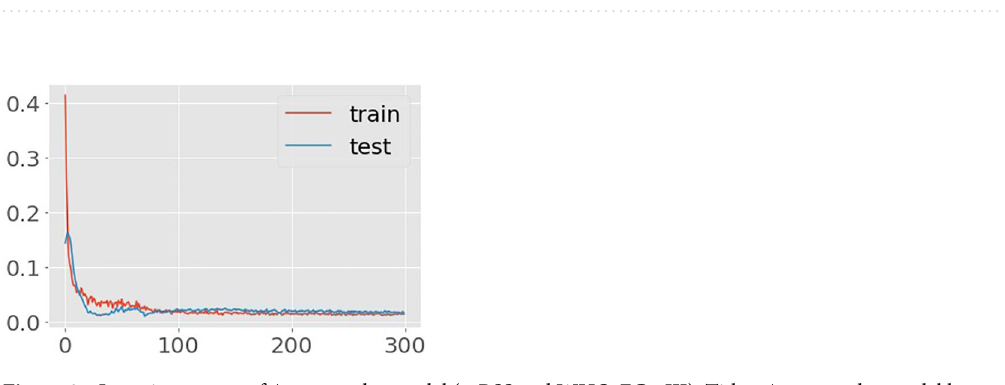
Figure 3. Learning curves of Autoencoder model (mRSS and WHO-FC ≥ III). Title = Autoencoder model loss. X-axis = Loss. Y-axis = number of